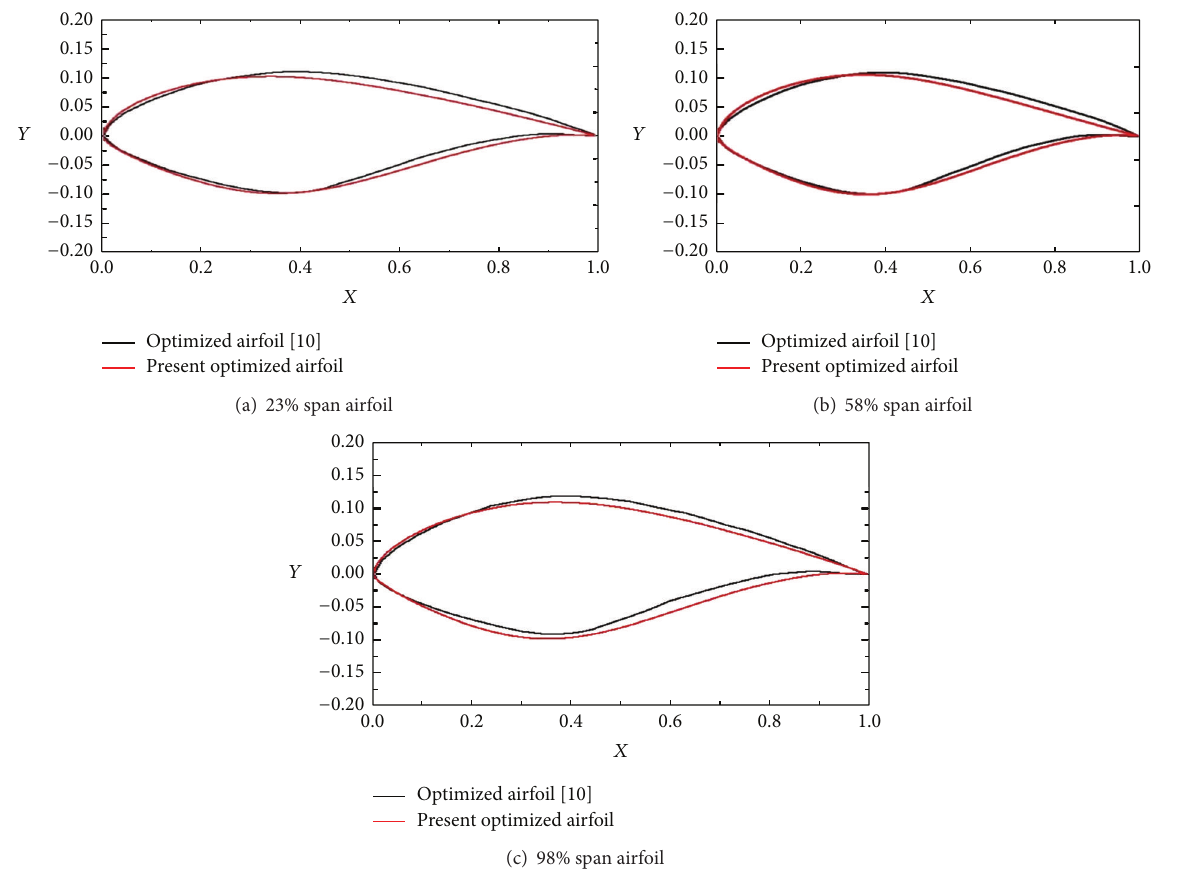
Figure 14: Comparison of present optimized airfoil shapes with those of Ritlop and Nadrajah